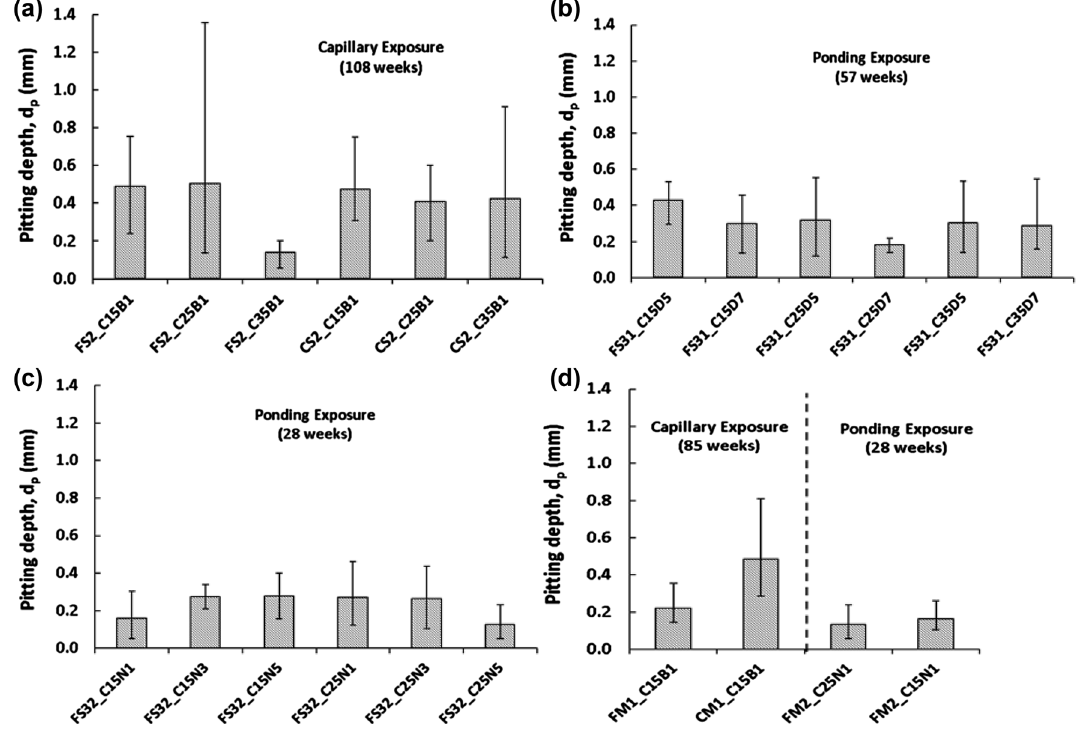
Fig. 9 Measured pitting depth due to corrosion of steel in R/SHCC and R/mortar specimens.